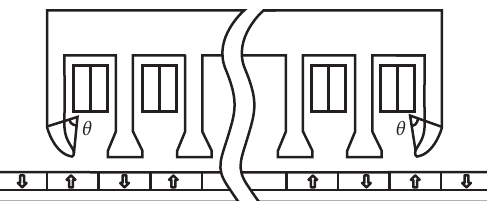
Figure 11: Edge radian of end tooth on the actuator.